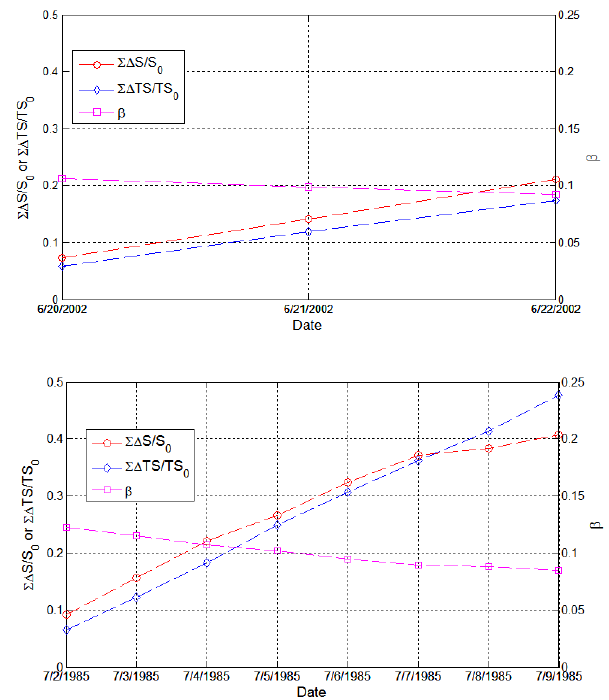
Fig. 9. Change of ∑∆S/S 0 , ∑∆TS/TS 0 and β during two recession events in the Spoon River Fig. 9. Change of P 1S/S 0 , P 1 TS/TS 0 and β during two re- Fig. 10. Change of P 1S/S 0 , P 1 TS/TS 0 and β during two reces- Fig. 10. Change of ∑∆S/S 0 , ∑∆TS/TS 0 and β during two recession events in the Big Nemaha cession events in the Spoon River watershed: (a) May 1994 and sion events in the Big Nemaha River watershed: (a) June 2002 and watershed: 1) May, 1994 and 2) October, 1988. (b) October 1988. (b) July 1985. River watershed: 1) June, 2002 and 2) July, 1985. the large difference between 1S and S 0 and the constant ¯ α can contribute to the stability of the β value, it is not the only factor.